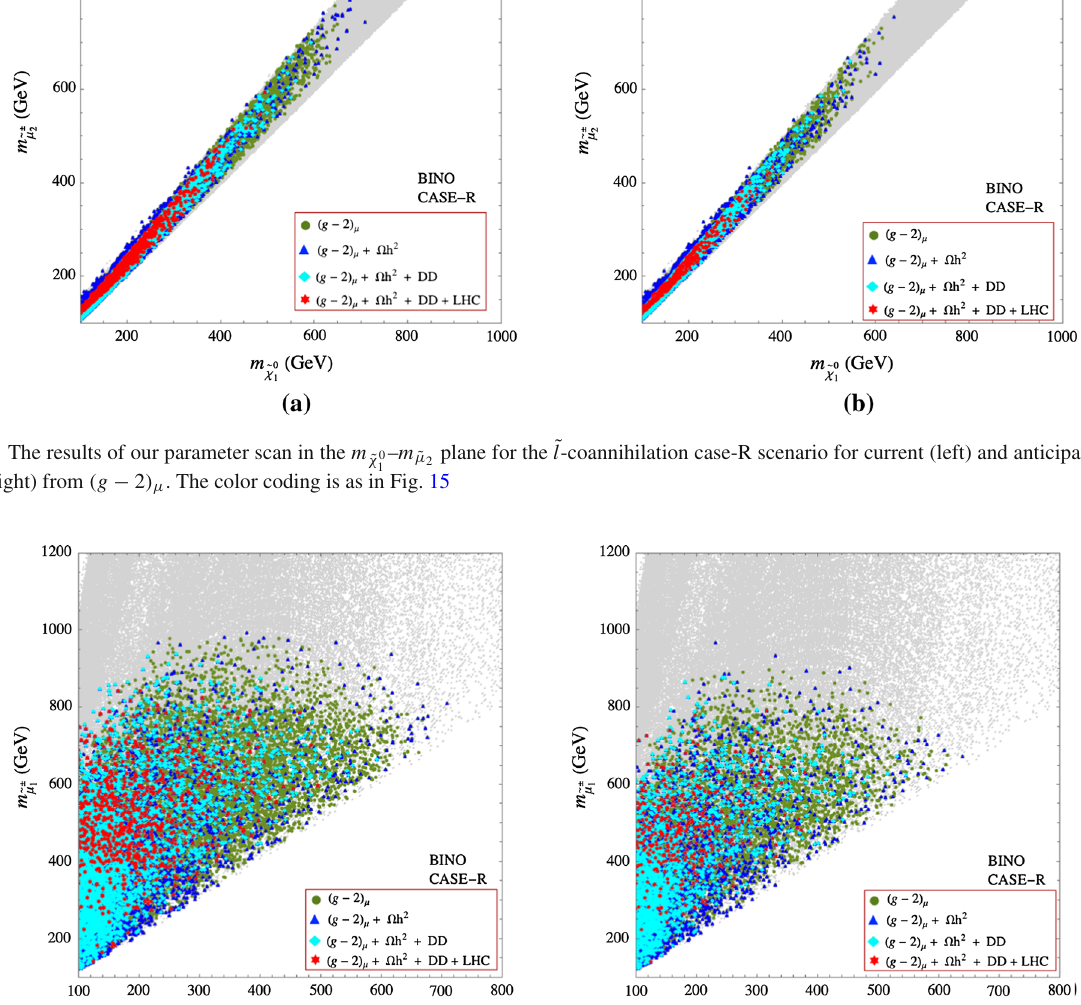
– m ˜ μ plane for the ˜ l -coannihilation case-R scenario for current (left) and anticipated future 1 1